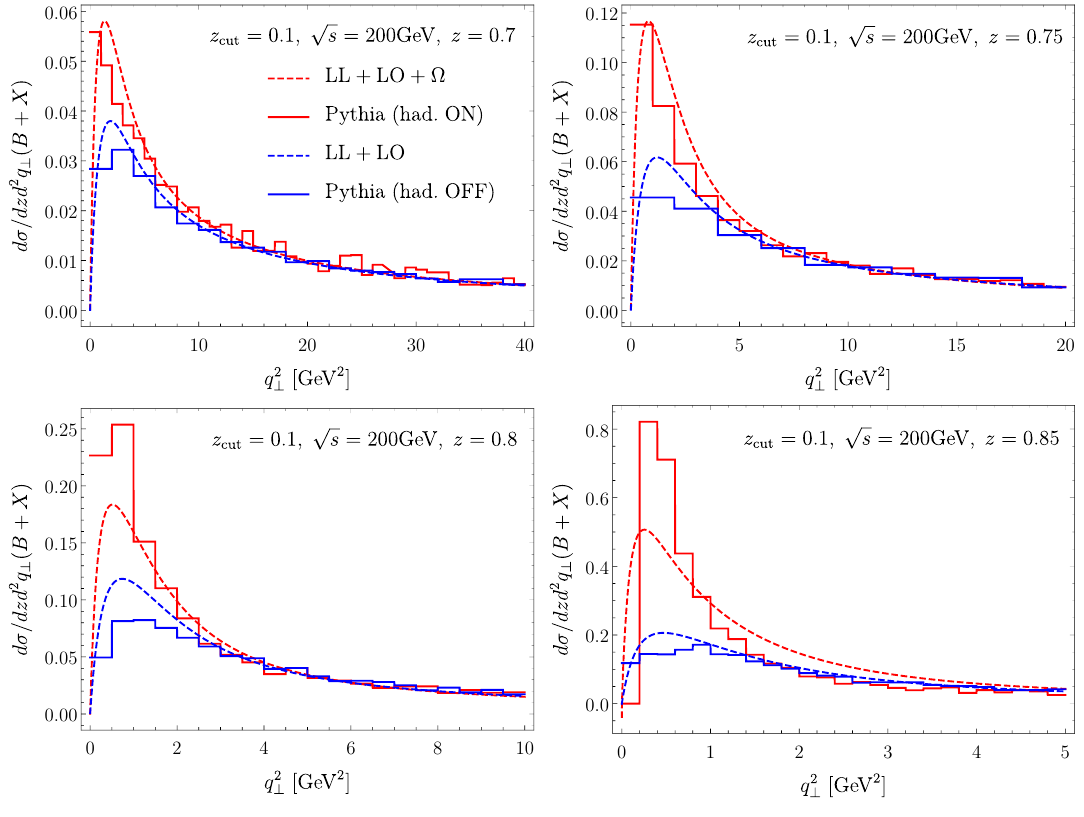
Figure 6 . Hadronization e(cid:11)ects in Pythia versus the simpli(cid:12)ed prescription of eq. (5.8). The results are shown for various values of the momentum fraction, particularly we choose z = 0 : 7 ; 0 : 75 ; 0 : 8 ; and 0 : 85. We (cid:12)nd that, as expected, the simple shift works better for values away from the energy threshold, 1 z cut (cid:0)